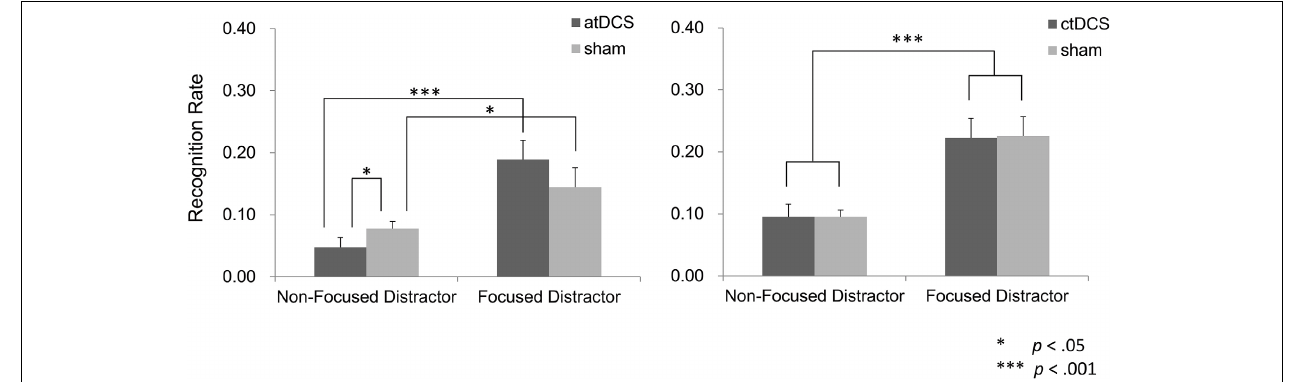
FIGURE 6 | Recognition performance of the distractor words. In the atDCS group, atDCS and sham stimulation tended to produce different effect across a type of distractor words. Specifically, difference in recall